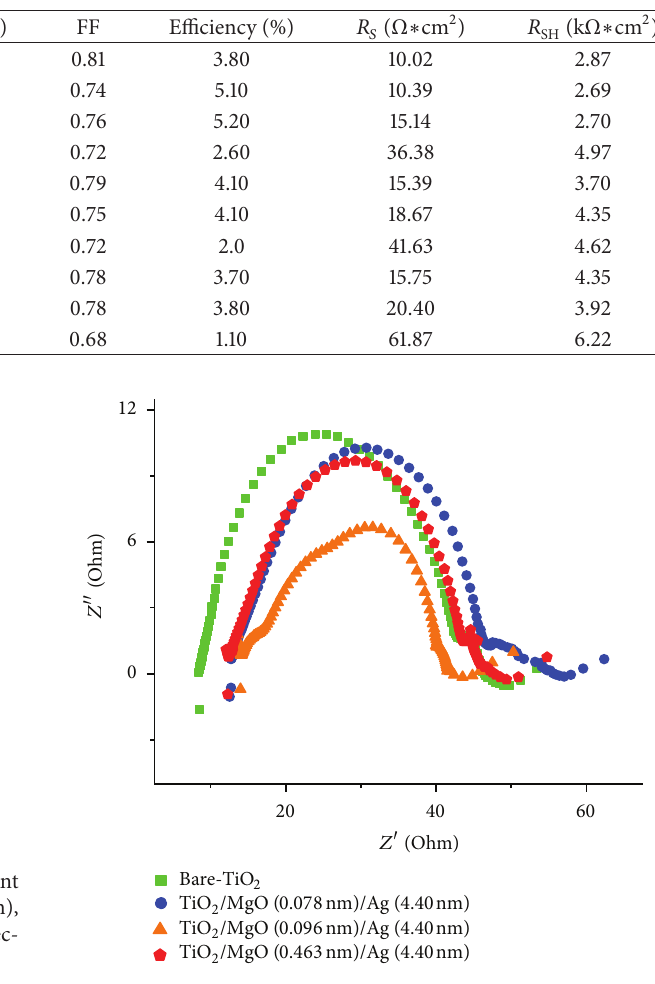
Figure 13: Electrochemical impedance spectra (EIS) of DSSCs with the TiO 2 /MgO/Ag (4.4 nm) electrodes with varied thickness of